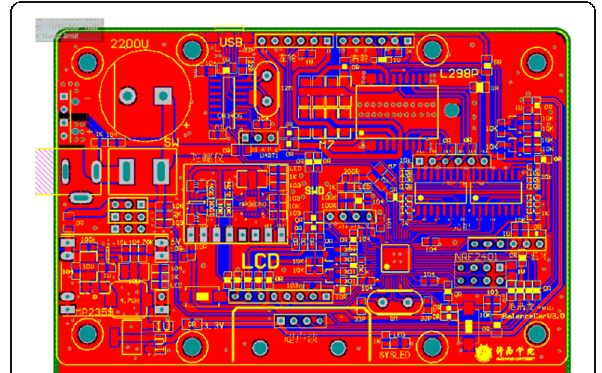
Fig. 33 Map of top-layer wiring of PCB